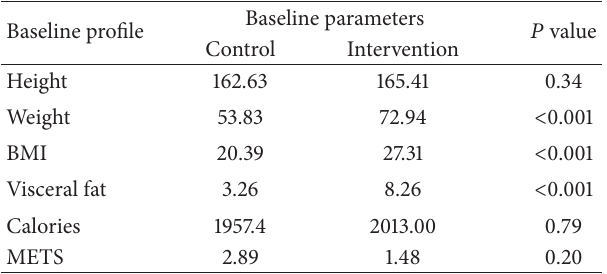
Table 1: Baseline parameters of the two